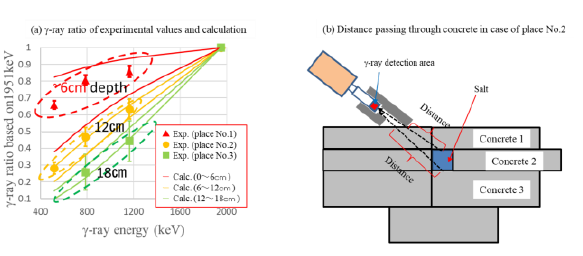
Fig.7 Salt distribution evaluation method with PGAA Fig.5 Diffractometer of RANS without